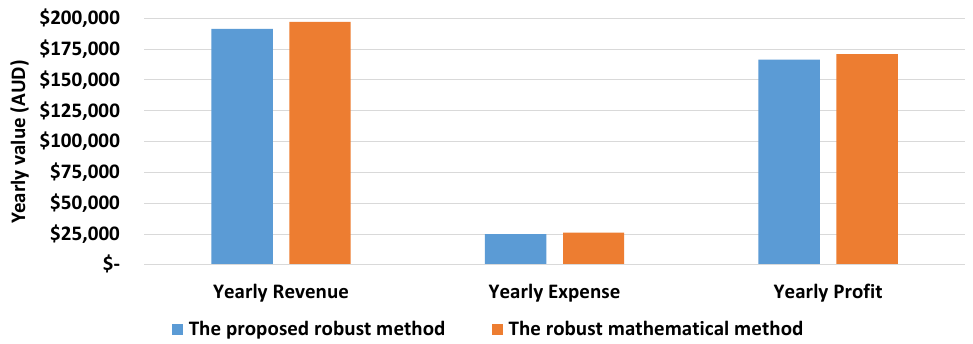
Figure 13. The yearly revenue, expense, and profit comparison between the proposed robust method and the mathematical robust method for participating in the energy market only.